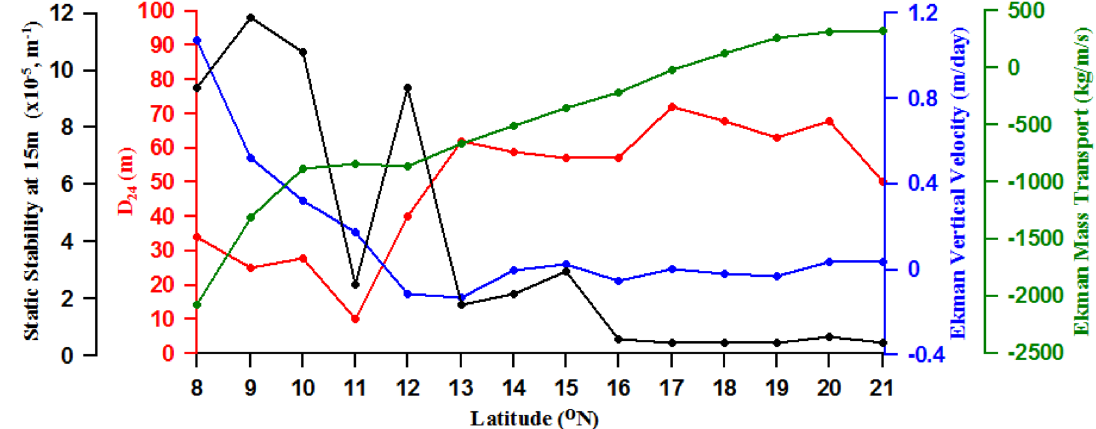
Figure 4. Latitudinal variation of Ekman mass transport (EMT) (kg/m/s, green solid line), Ekman vertical velocity (m/day, blue solid line), static stability in the upper 15 m of the water column (m −1 , black solid line), and depth of 24 °C isotherm (D 24 ) (m, red solid line) from 8° to 21° N along the eastern Arabian Sea during August